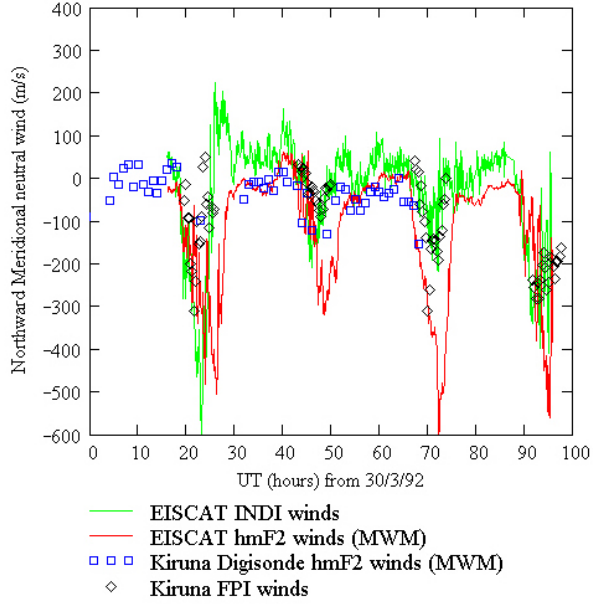
Fig. 4. Thermospheric meridional winds from four techniques for 3 consecutive days beginning at 00:00 UT on 08 August 1991.